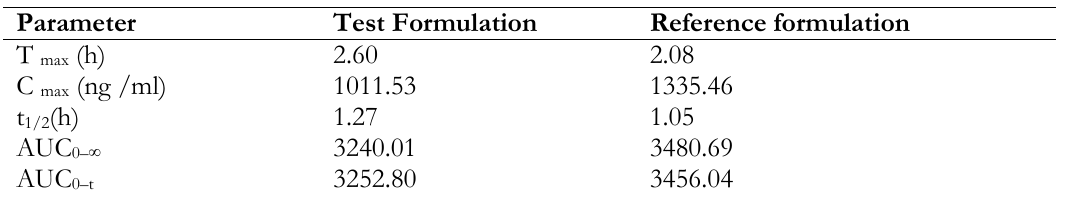
Table V. Mean pharmacokinetic parameter following Oral administration of 20mg tablet formulation (Test and Reference) of Omeprazole in 20 healthy human